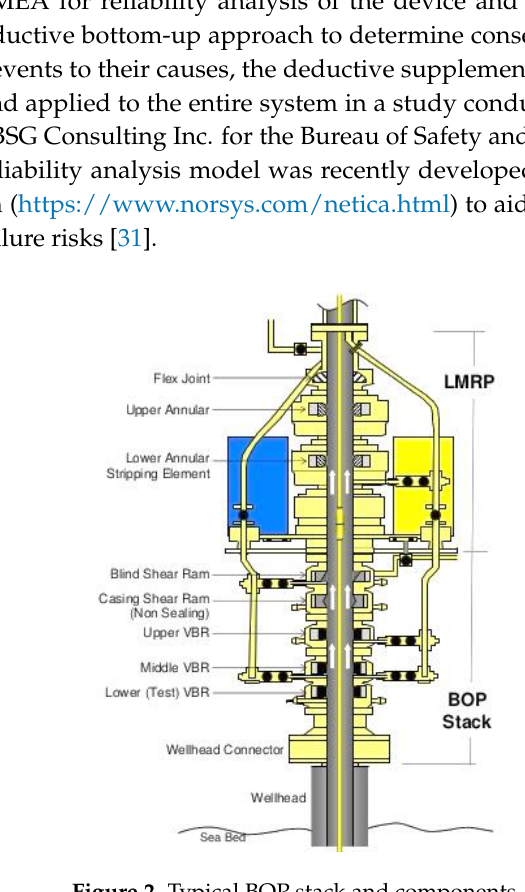
Figure 2. Typical BOP stack and components.